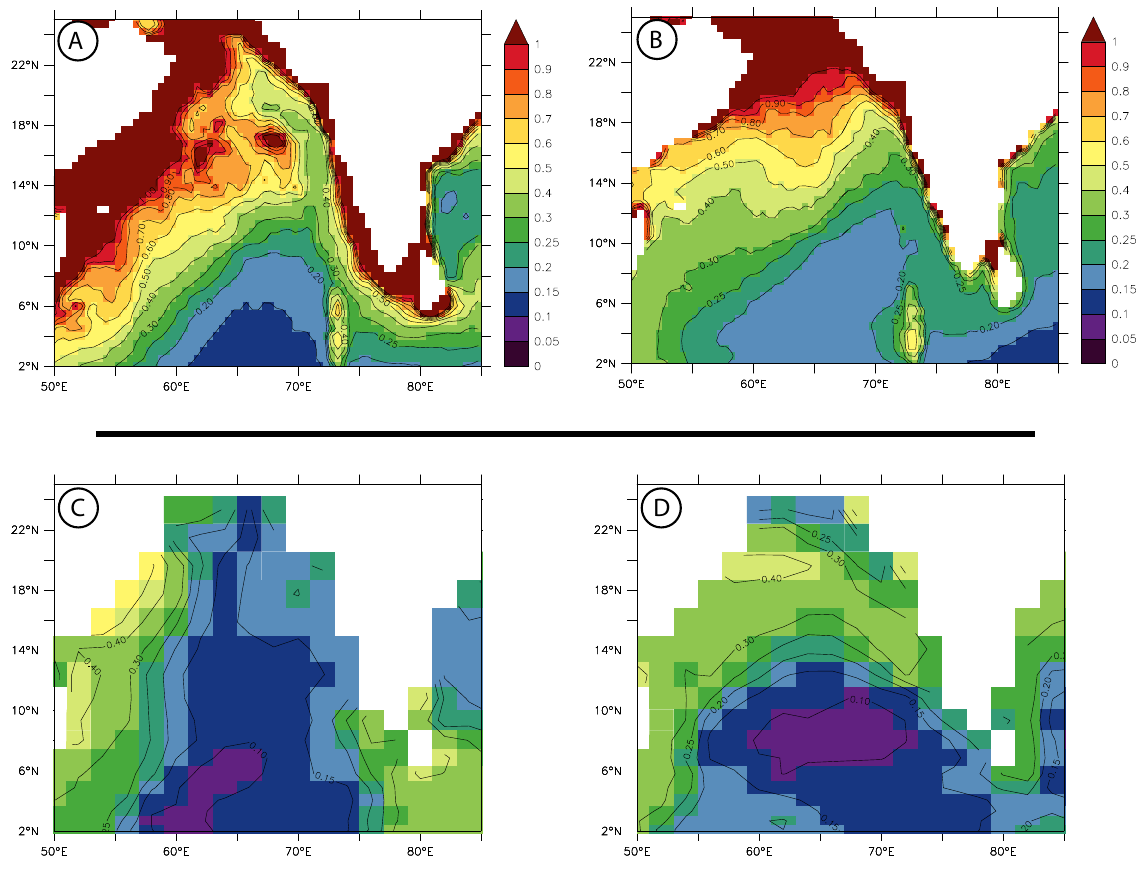
Fig. 2. Seasonal distribution of chlorophyll abundance (mgm − 3 ) in the Tropical Indian Ocean (SeaWiFs data) during the summer (A) and winter (B) seasons. PISCES simulations of chlorophyll concentration (mgm − 3 ) for the summer (C) and winter (D)